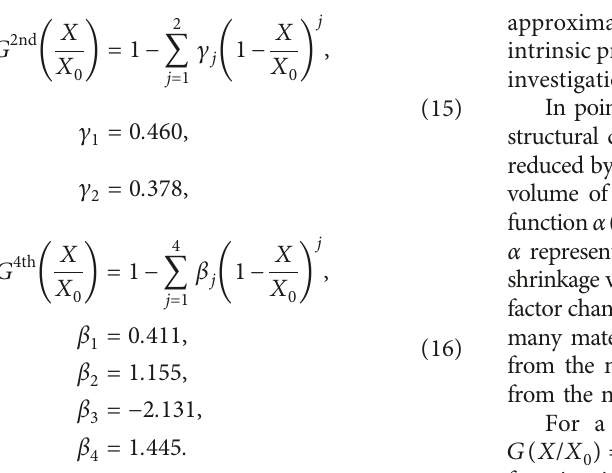
Figure 1: Experimental data L / L X / X 0 vs. 0 for chayote discoid samples at four different temperatures best fit with (a) a second-order polynomial function G 2nd (equation (15)) and (b) a fourth-order polynomial function G 4th (equation